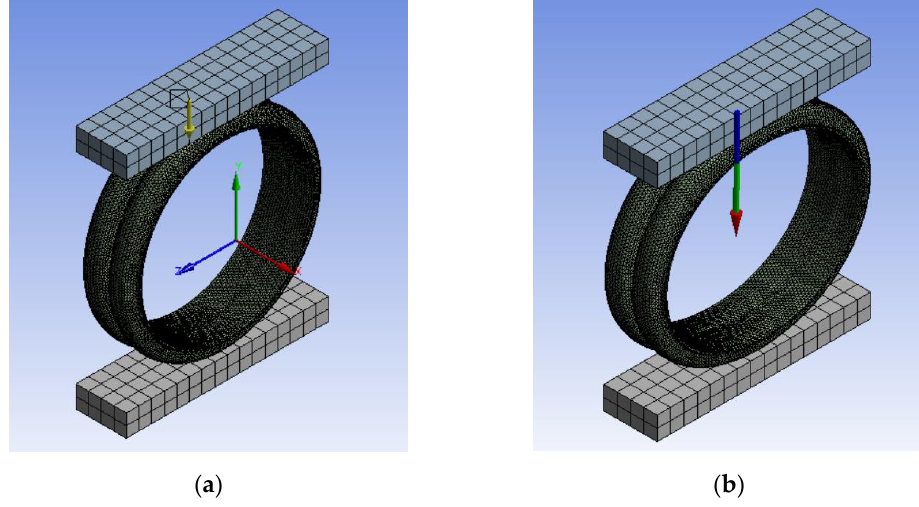
Figure 10. Finite element model of bellows ring stiffness calculation. ( a ) Schematic diagram of steel plate displacement; ( b ) Schematic diagram of reaction force.